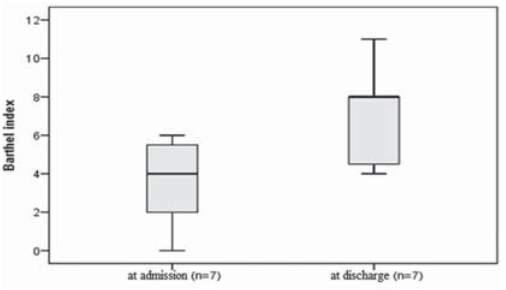
FIGURE 2. Barthel index at admission and discharge (Z=- 2.120; P=0.047).